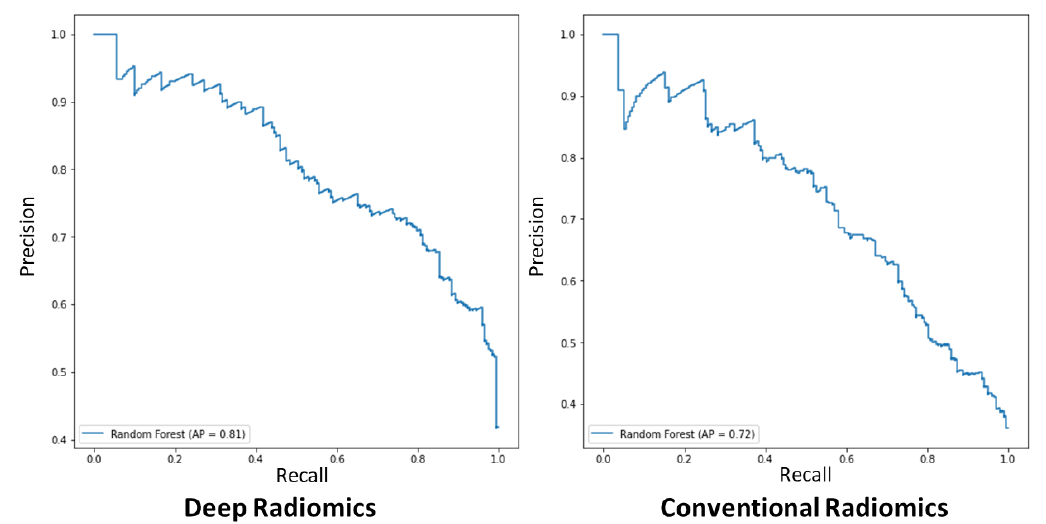
Figure 7. The representation of conventional and deep radiomic features for the training random forest model for diagnosis of breast cancer with the respect to precision and recall.